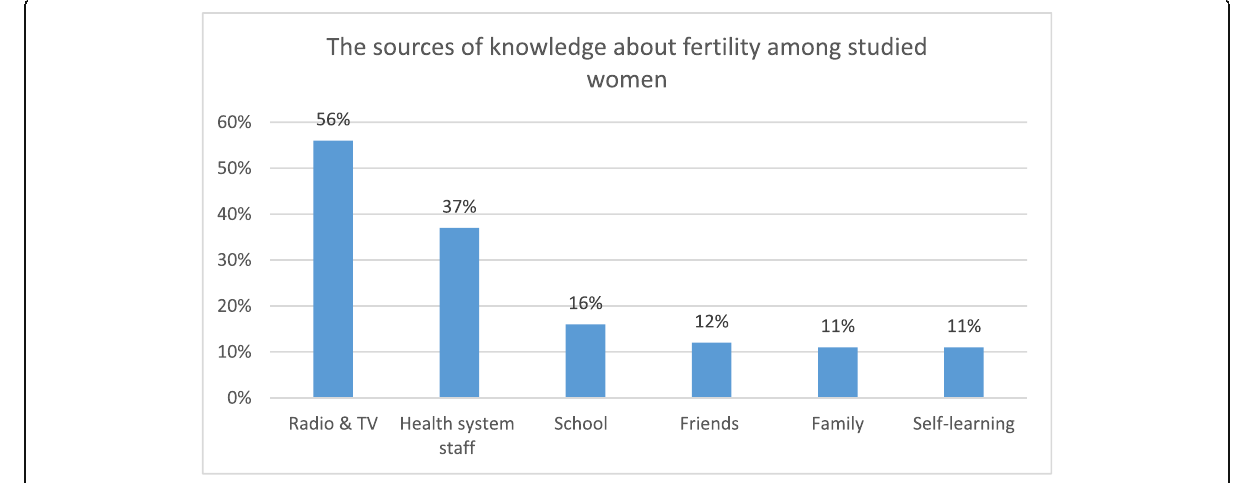
Fig. 1 The sources of knowledge about fertility among studied women